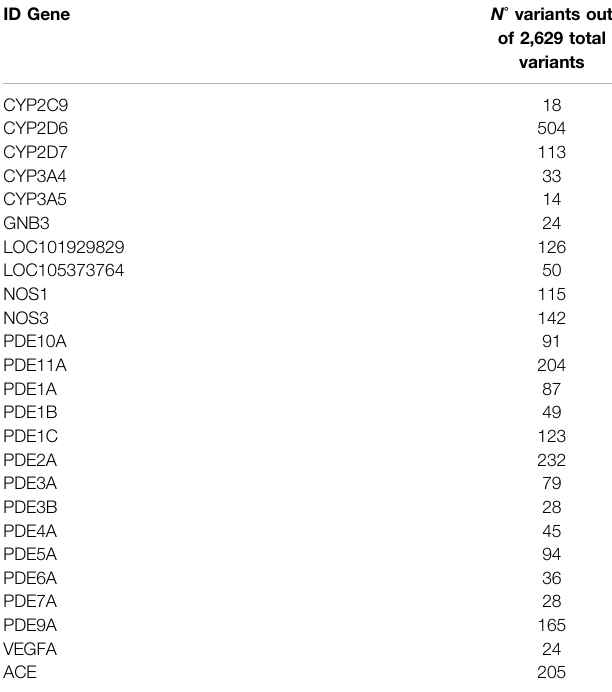
TABLE 2 | The gene panel evaluated in 28 male patients with erectile dysfunction included in the study and the corresponding number of gene variants. ID